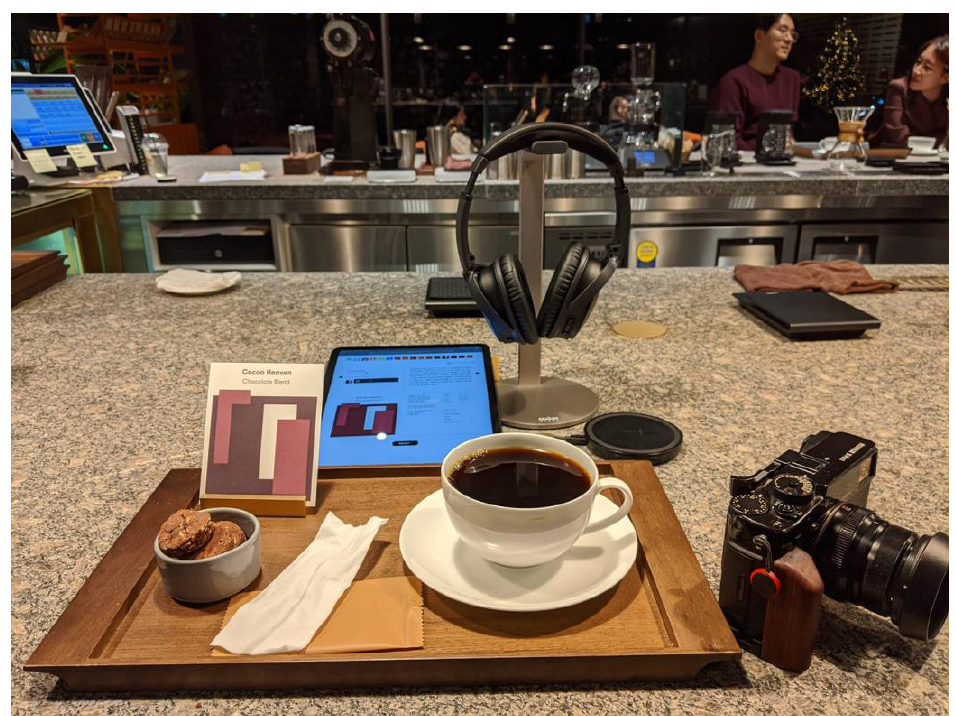
Figure 1. Korean coffee-shop where music is paired with the choice of coffee designed to match the Figure 1. Korean co ff ee-shop where music is paired with the choice of co ff ee designed to match the customer’s taste preferences. customer’s taste preferences. Foods 2020 , 9 , x FOR PEER REVIEW 13 of 22